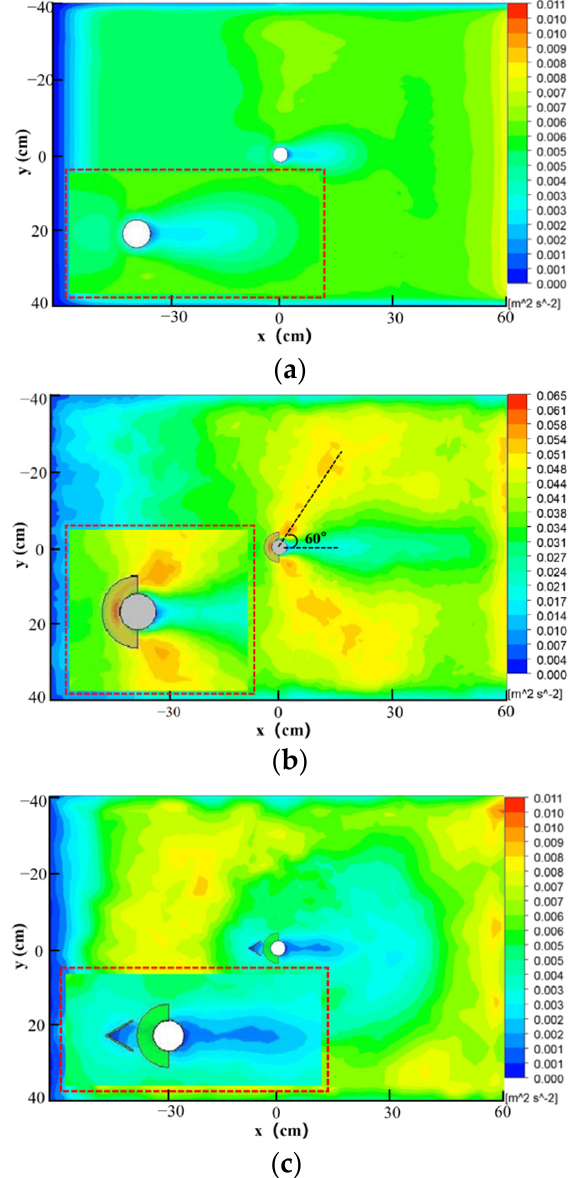
Figure 12. Turbulence kinetic energy at Z = 1 cm. ( a ) Single pier; ( b ) Pier with ring-wing plate; ( c ) Pier with combined device.